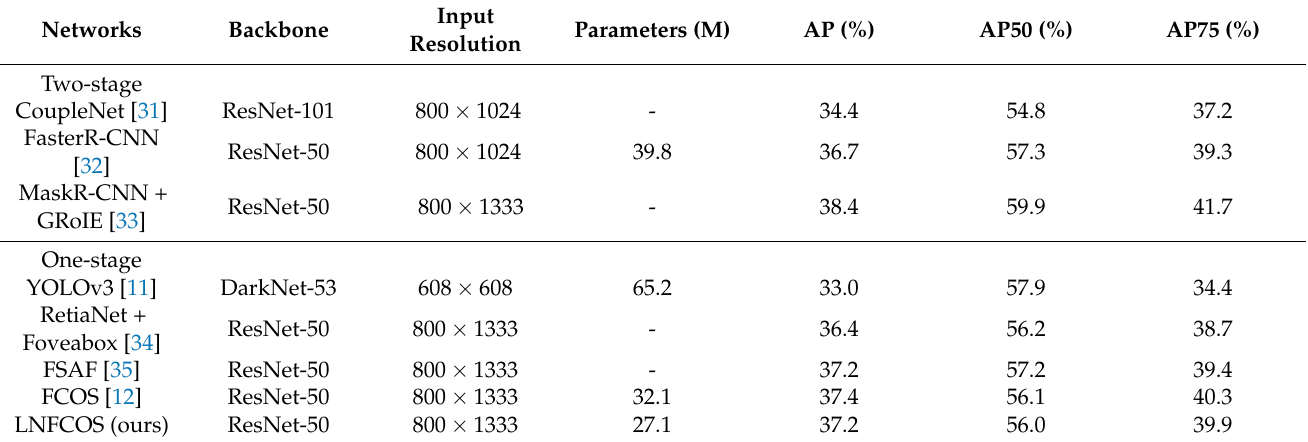
Table 3. Comparison of other networks using the MSCOCO 2017 minival dataset.